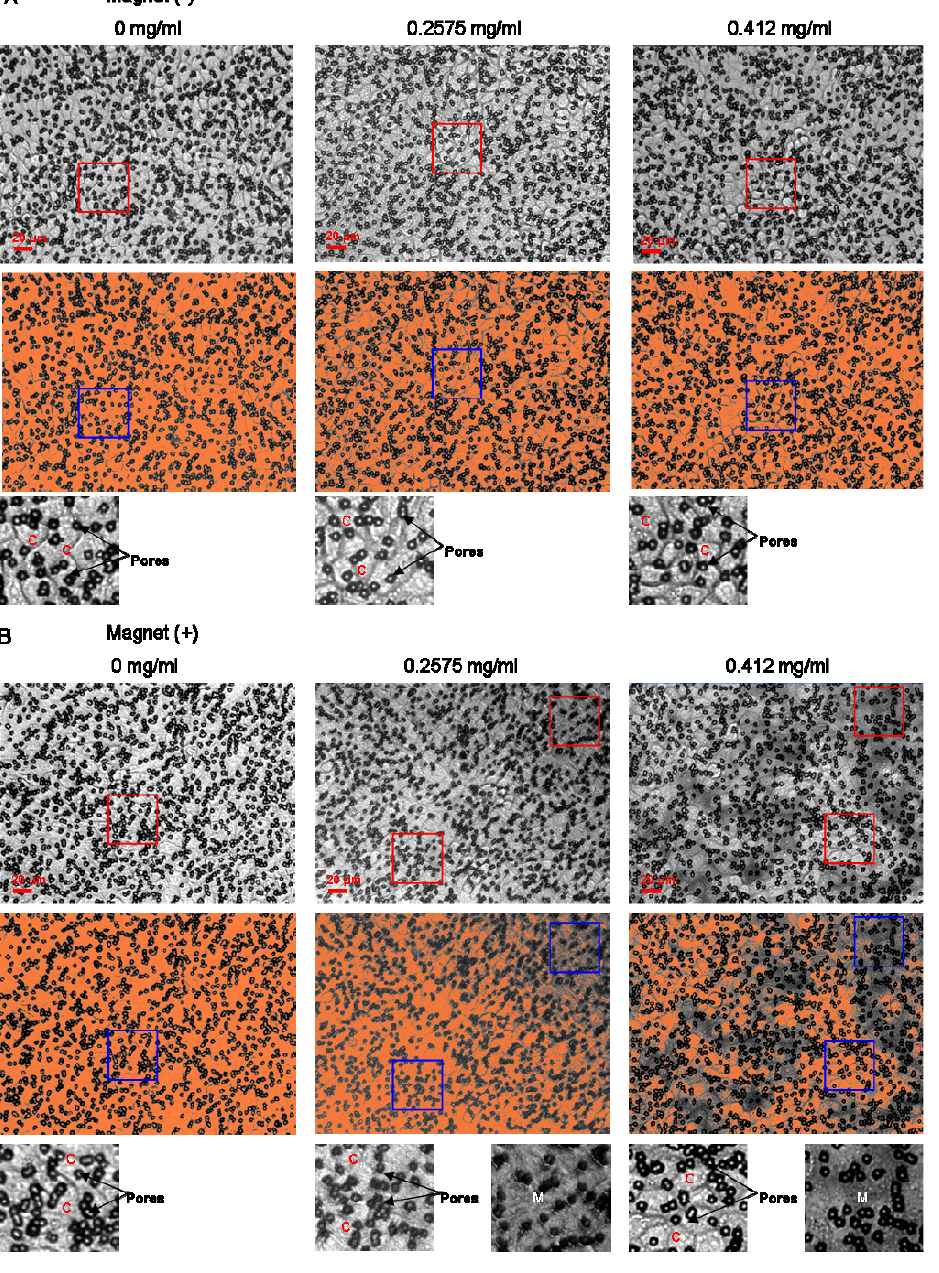
Figure 5. Bright field microscopy of MDCK cell monolayers on polyester membrane (pore size: 3  m) after transport experiments with Hep-MION. The cell monolayer without (A) or with the magnetic field (B) is shown (20 × magnifications). Beneath each image of the cell monolayers, the regions of the monolayer that do not exhibit shading due to the dark nanoparticle aggregates are highlighted in orange. Zoom-in regions are indicated with red and blue boxes in the original and highlighted orange images. The dark pores (size: 3  m) (indicated with arrows labeled “Pores”) are randomly distributed on the membrane and pointed to in the zoom-in images with the cells (C) . With an applied magnetic field, the darker regions (in zoom-in images) of the cell monolayer reflect accumulation of magnetic nanoparticles (“M”) in association with the cell monolayer (0.2575 or 0.412 mg/mL). Scale bar corresponds to 20 µm in the bright field